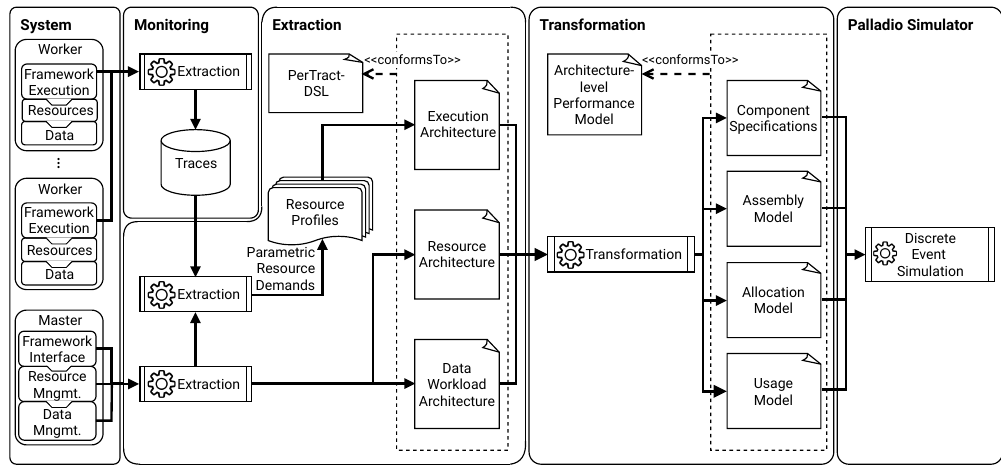
Figure 1. Overview of the extraction and transformation